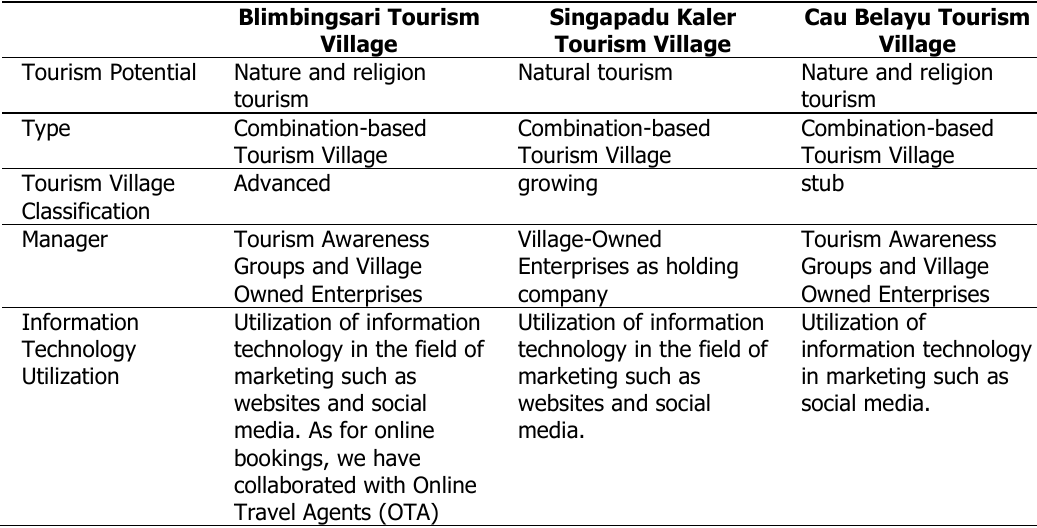
Table 3. Utilization of Information Technology in Tourism